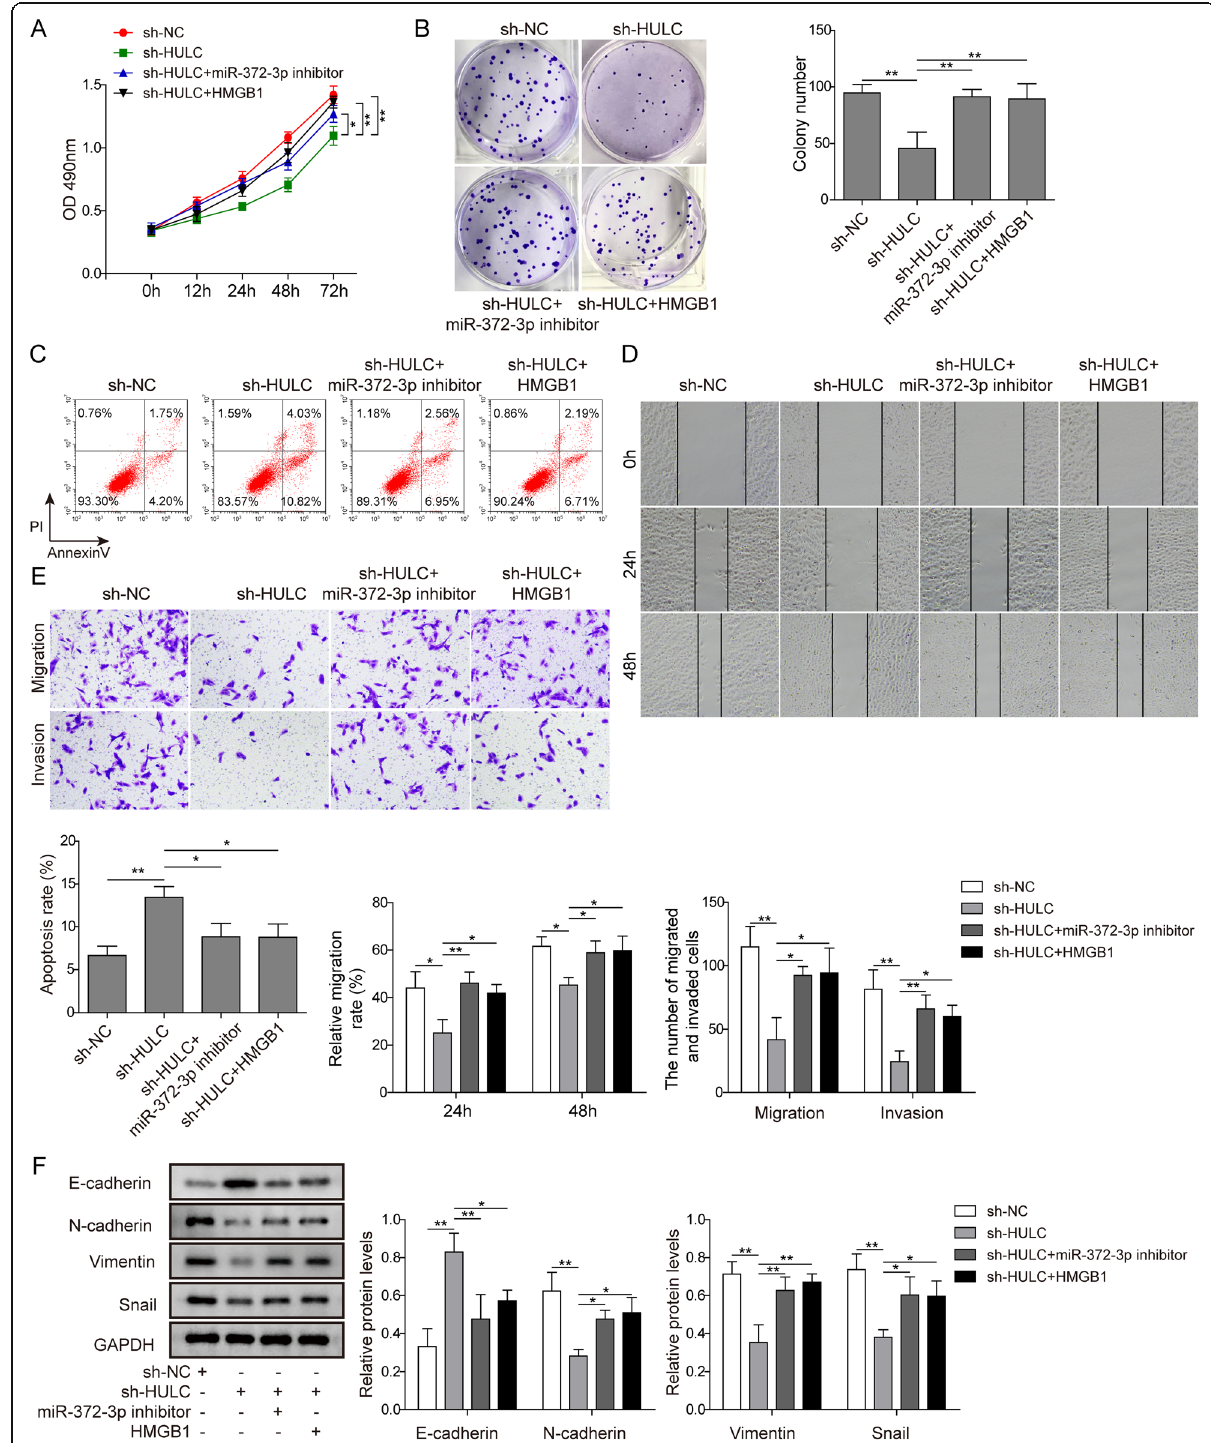
Fig. 6 HULC regulated osteosarcoma cells via the miR-372-3p/HMGB1 signalling pathway. U2OS cells were transfected with sh-NC, sh-HULC, sh- HULC together with miR-372-3p inhibitor, or sh-HULC together with HMGB1 overexpression vector. Cell proliferation was tested by CCK-8 assay (A) and colony formation assay (B); cell apoptosis was analysed by flow cytometry (C); cell migration and invasion were detected by wound healing assay (D) and transwell assay (E); and the expression levels of E-cadherin, N-cadherin, vimentin and Snail were analysed by western blot (F). Data are shown as the mean ± SD. * p < 0.05, ** p <